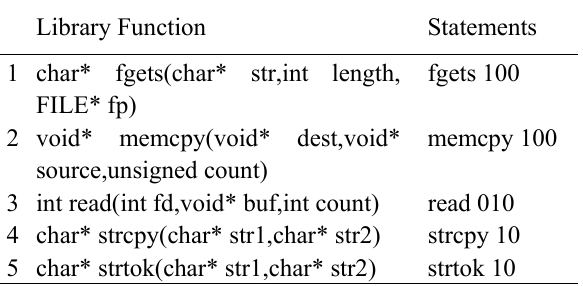
Table 1. express of some output parameters Library